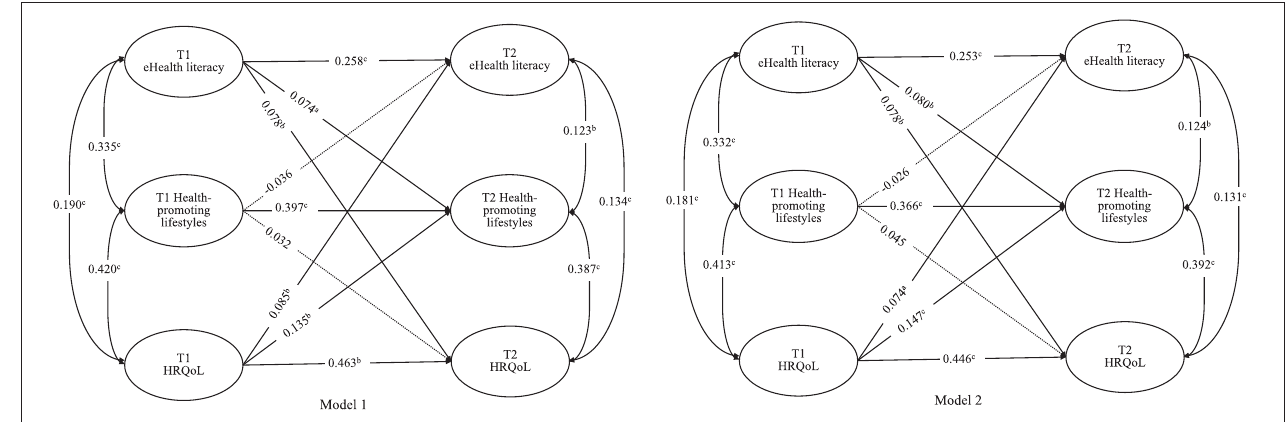
FIGURE 1 | Cross-lagged analysis of eHealth literacy, health-promoting lifestyles and HRQoL at two time points. Model 1 was unadjusted models. Model 2 adjusted for age, sex, Chinese ethnic groups residence and academic major, and self-reported family economic level, the standardized coefficients of the control variables were not displayed in the model but were included in the analyses. a P < 0.05, b P < 0.01, c P < 0.001; All coefficients are standardized coefficients; The solid line represents the path that is statistically significant ( P < 0.05), and the dashed line represents the path that is not statistically significant ( P > 0.05).